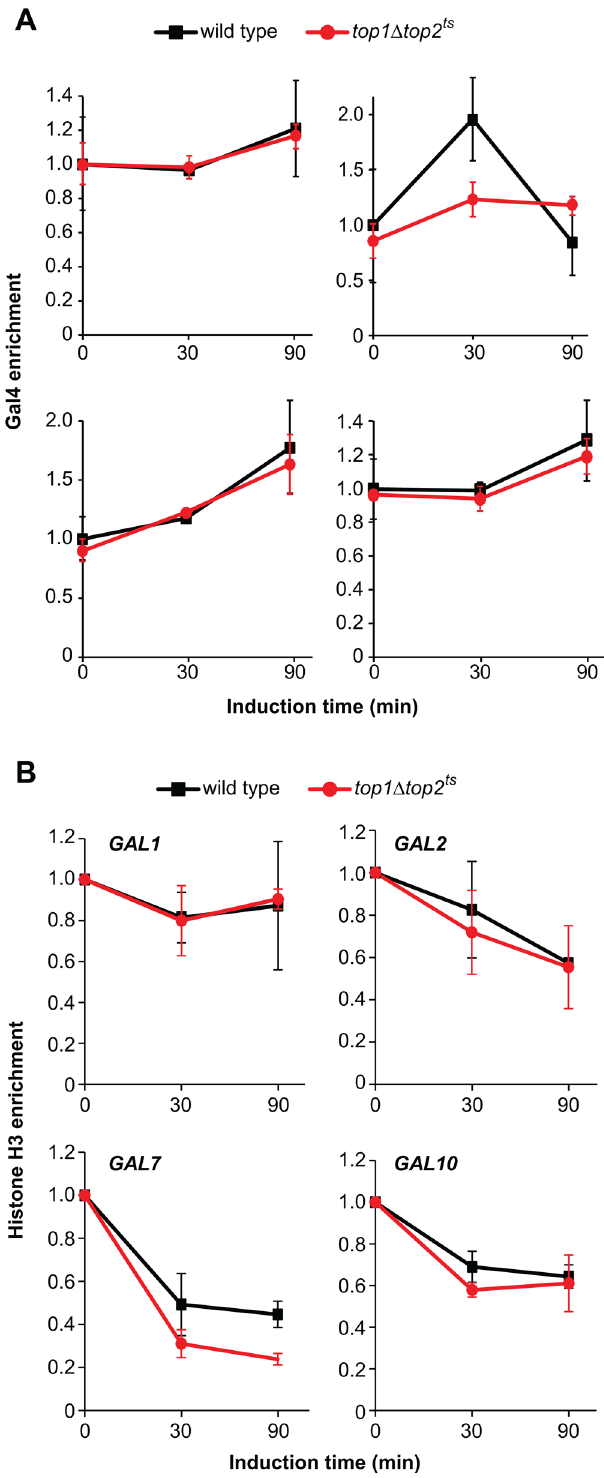
Fig 3. Promoter chromatin remodeling is not affected by lack of topoisomerases. (A) ChIP analysis of Gal4 binding in the GAL gene promoters of wild type and top1 Δ top2 ts cells following transcriptional activation. Experimental setup was as described for Fig 1B, and ChIP was performed using antibodies against Gal4. Gal4 binding levels in the GAL gene promoters were normalized to the binding under